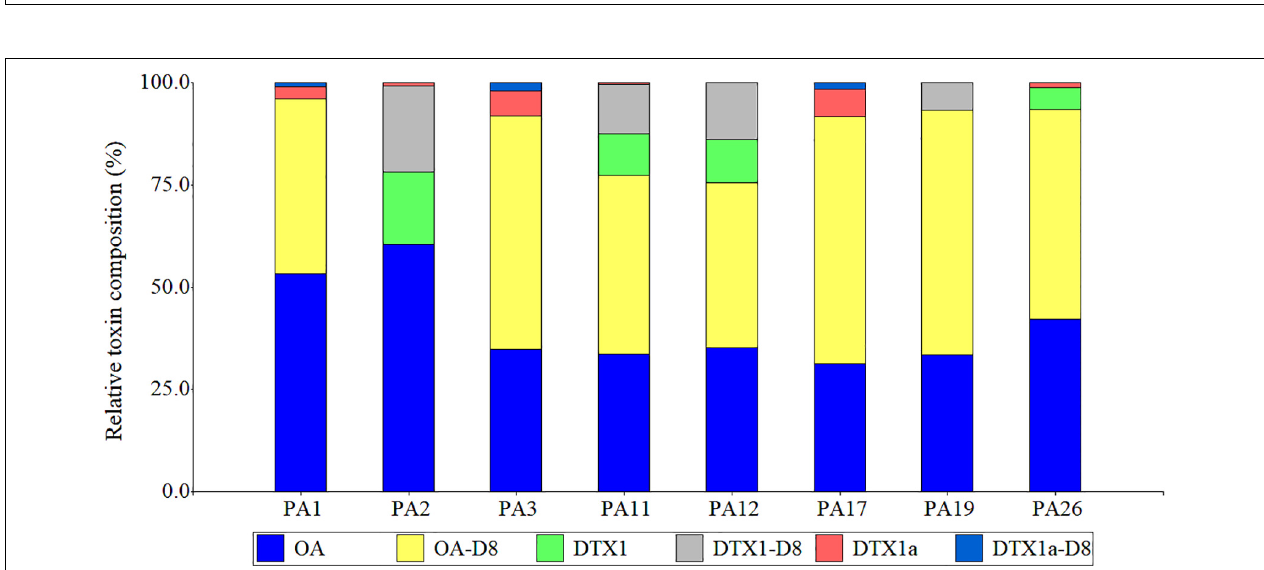
FIGURE 5 | Relative toxin composition (%total concentration) of DSP toxins (OA and DTX analogs) from cultured benthic Prorocentrum isolates from the Veracruz Reef System and the Mexican Caribbean coast. OA, okadaic acid; OA-D8, okadaic acid diol-ester; DTX1, dinophysistoxin 1; DTX1a, undescribed DTX1 isomer; DTX1-D8, dinophysistoxin1diol-ester; DTX1a-D8, undescribed DTX1-D8 isomer.